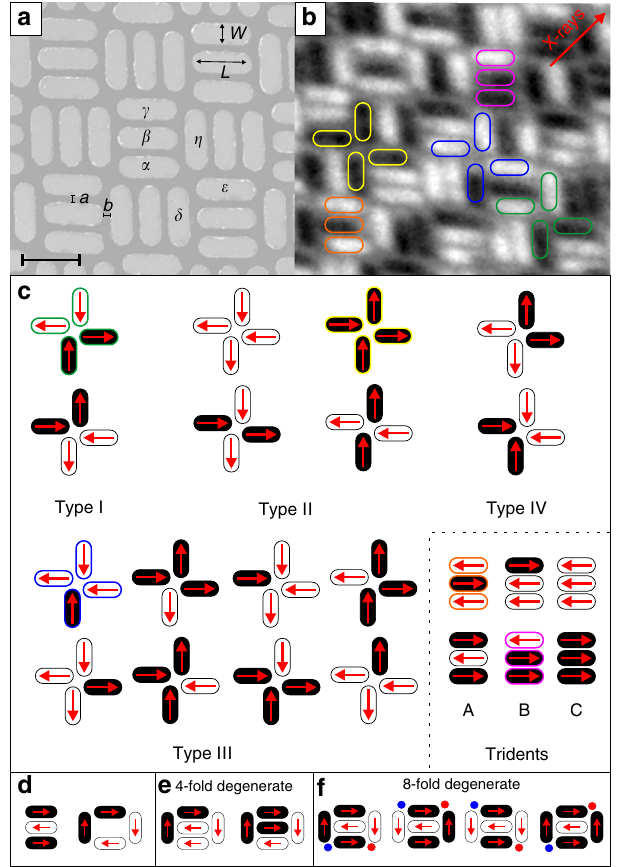
Fig. 1 The dipolar trident lattice. a Scanning electron microscope image of a dipolar trident lattice ( a = b = 50 nm, L = 450 nm, W = 150 nm). The black scale bar indicates a length of 450 nm. b X-ray magnetic circular dichroism (XMCD) image resolving moment con fi gurations achieved in the trident lattice. Nanomagnets with a magnetization pointing toward the incoming X- ray propagation vector (indicated by a red arrow) appear dark, while moments opposing that direction appear bright. c Vertex and trident types listed with increasing energy. In both b , c green, yellow, and blue frames highlight the realizations of Type I, Type II, and Type III vertices, respectively. Regarding tridents, Type A and B tridents are highlighted with orange and magenta frames, respectively. d Minimization of dipolar interactions in an isolated trident building block would result in a Type A domination. On the other hand, nearest-neighbor nanomagnets at the four- nanomagnet vertices will prefer a head-to-tail moment alignment, which would result in clockwise or anti-clockwise vortices. e Satisfying vertex interactions (creation of vortices or Type I vertices) results in frustration of trident moments. f Satisfying trident interactions (creation of Type A tridents) results in two of nearest-neighbor vertex moments being aligned head-to-head (red circles) or tail-to-tail (blue